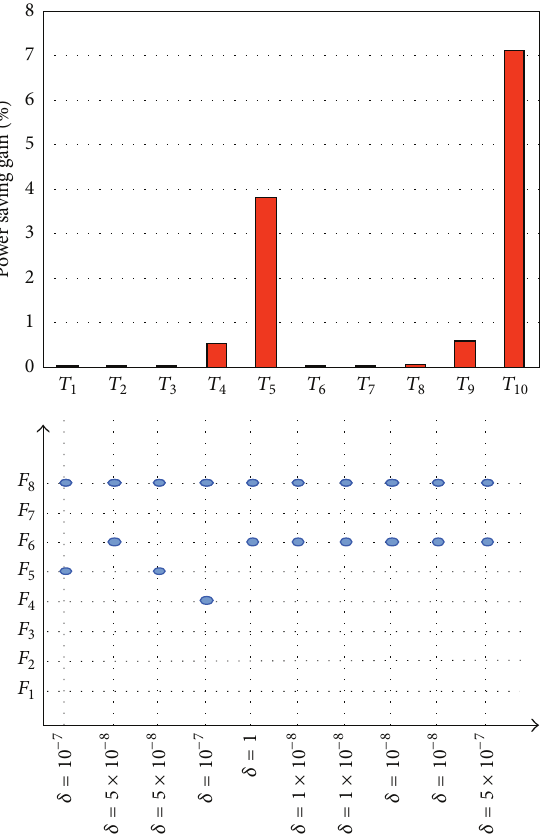
Figure 8: Power saving and selected configuration (𝛿,Φ) corre- sponding to a target loss probability of 10 −6 —2-frequency